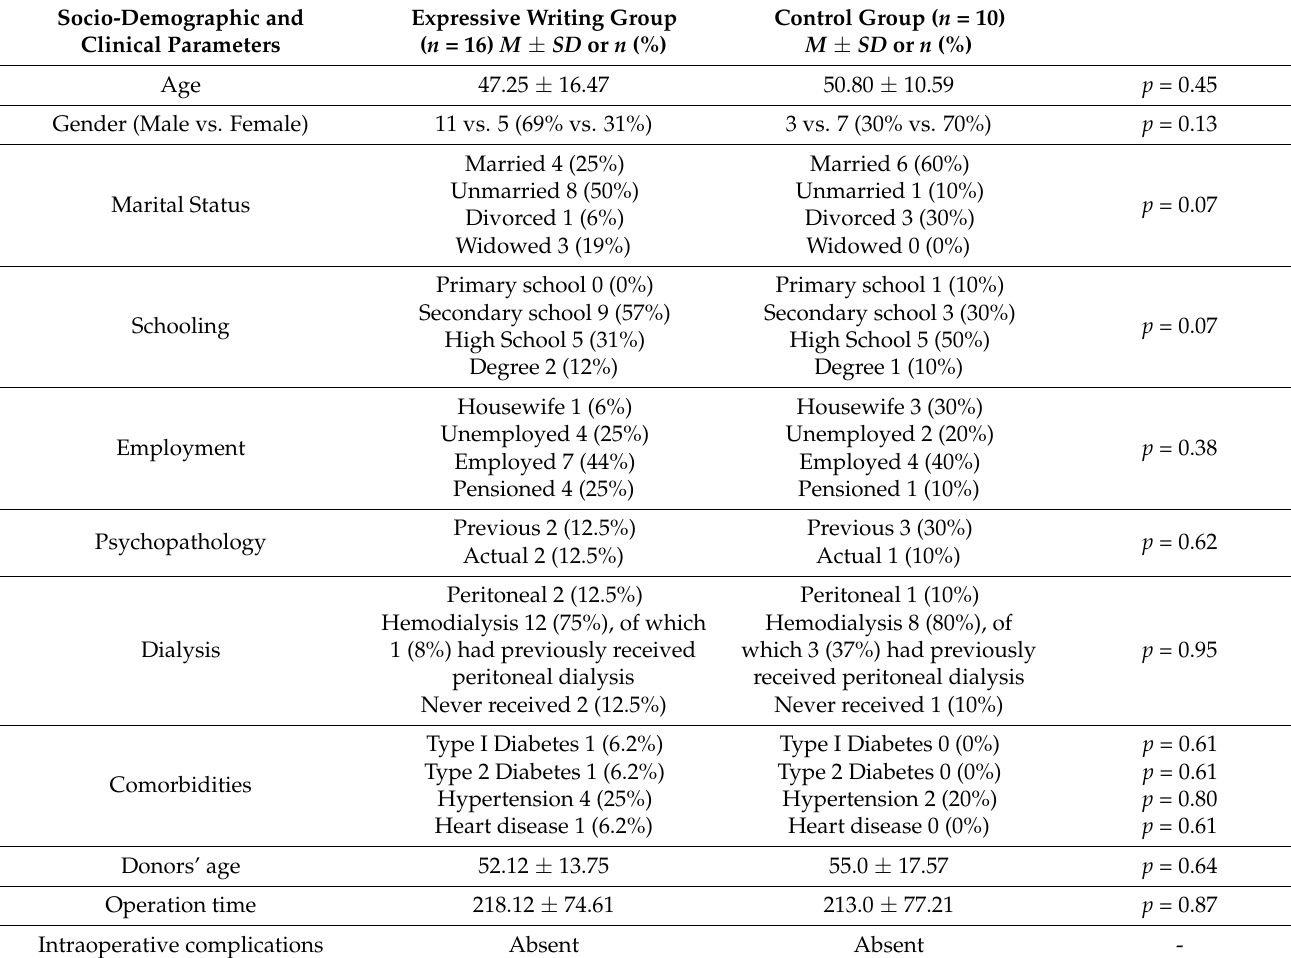
Table 1. Characteristics of the